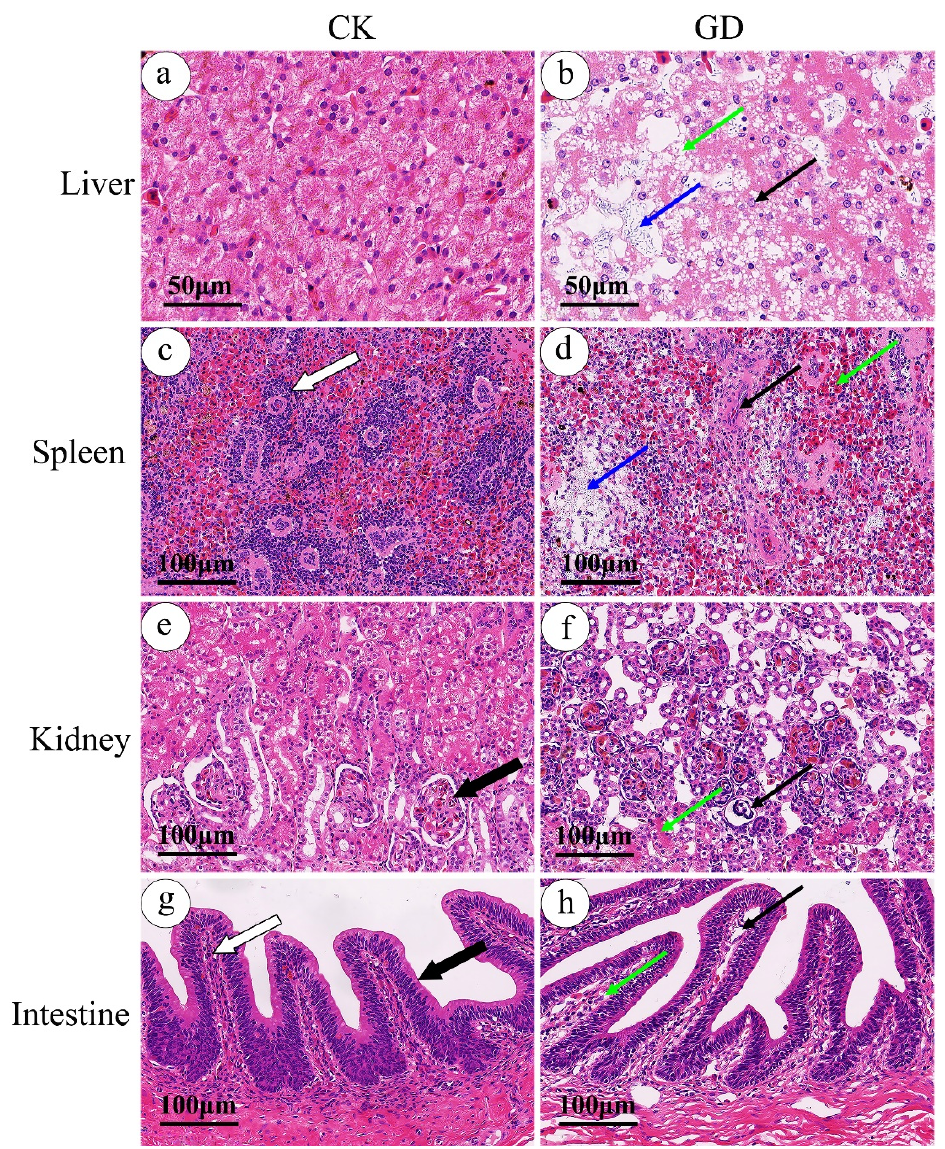
Figure 1. HE ‐ stained histological sections of livers, spleens, kidneys, and intestines. CK and GD represent the control group and infection group, respectively. Scale bars denote a length of 50 ( a , b ) or 100 μ m ( c – h ). The blue arrows point to bacterial accumulation universally. ( a ) The normal liver. ( b ) Collapse in a hepatic lobule (green arrow) and vacuolated cytoplasm due to nuclear pyknosis and karyolysis (black arrow). ( c ) Lymphoid follicle filled with an enormous number of lymphocytes in the control spleen (thick white arrow). ( d ) Atrophy and necrosis in a lymphoid follicle (black arrow) and overt hyperemia around lymphatic nodules (green arrow). ( e ) Healthy glomerulus with a distinct profile (thick black arrow). ( f ) Tubular necrosis (green arrow), and lymphocytic infiltrates and atrophy in glomeruli (black arrow). ( g ) The normal intestinal villi with morphologically normal lamina propria (thick white arrow) and goblet cells (thick black arrow). ( h ) Structural disorder of the lamina propria of the villi, with loose smooth muscle (green arrow) and damaged central chylomicron (black arrow).